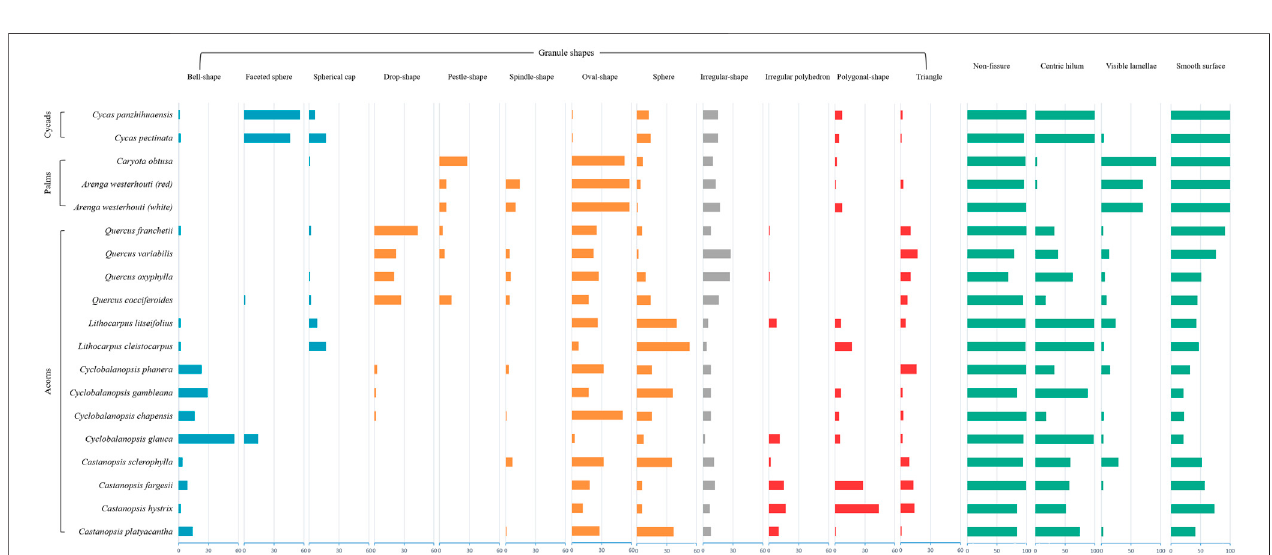
FIGURE 4 | Percentage distribution of morphological features among plant species (Data shown in Supplementary Table S2 ).